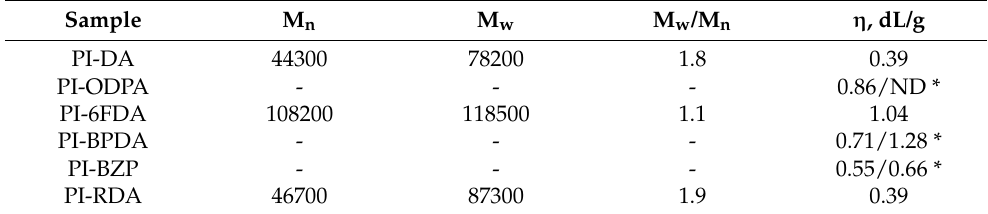
Table 2. Molecular weight characteristics of obtained PI.